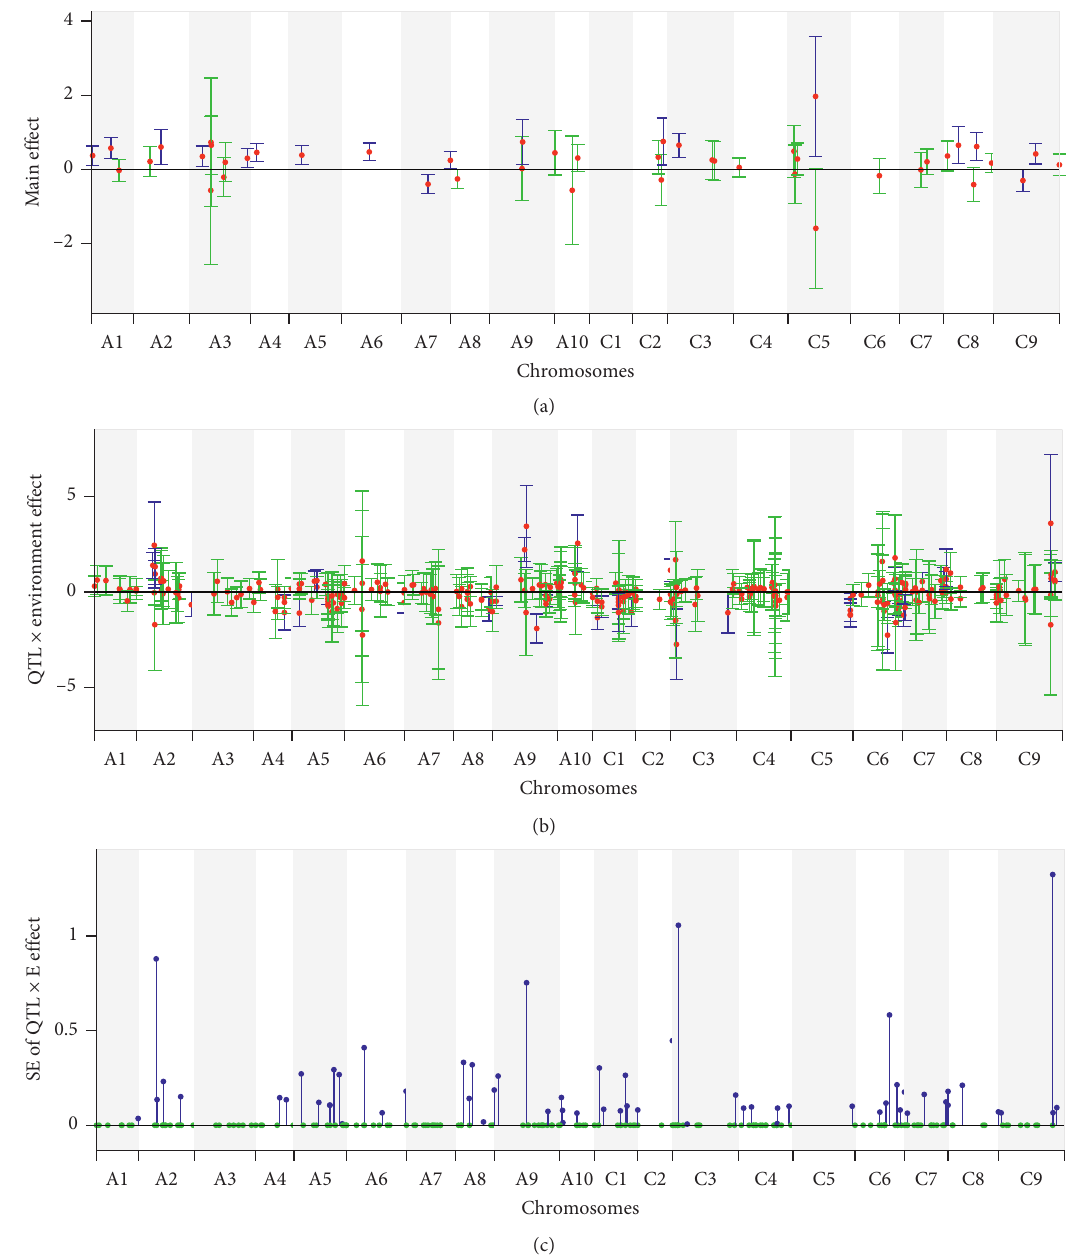
Figure 1: The point estimates and 95% confidence intervals (95% CI) for marker main and environment-specific effects and the standard error (SE) of environment-specific effects for FT. (a) Point estimates (red dots) and 95% CI for main effects (the vertical blue and green CIs represent statistically significant or nonsignificant values, respectively). (b) Point estimates (red dots) and 95% CI for environment-specific effects (the vertical blue and green CIs represent statistically significant or nonsignificant values, respectively). (c) SE for environment- specific effects (the blue and green stems represent environment-specific effects found in multiple environments or only one environment,